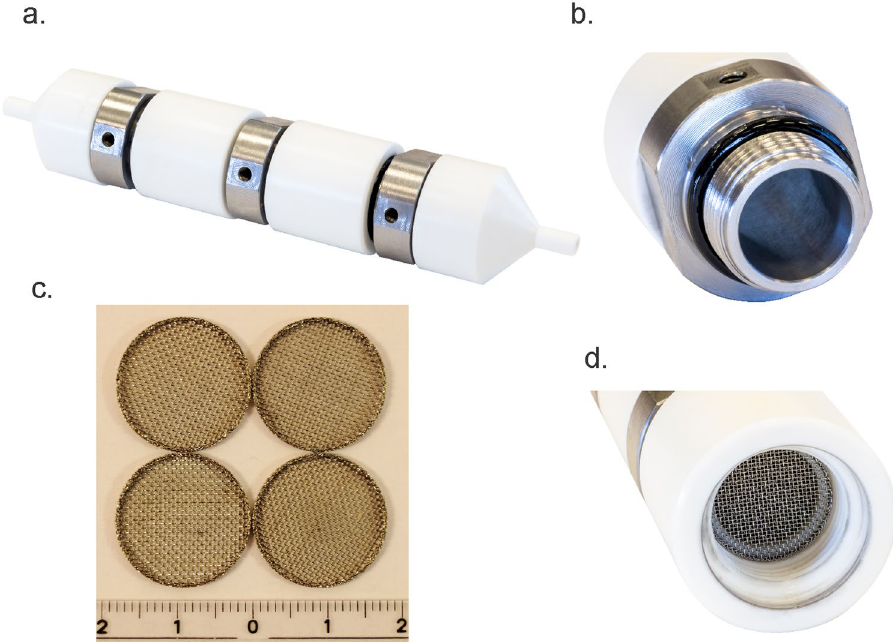
Figure 4. The structure of MSFT chamber ( a ) exterior of assembled chamber with pipelines connections, ( b ) the stainless steel meshes acting as electrodes in one of the two active treatment regions ( c ) the undamaged stainless steel mesh electrodes after PEF treatment with the rule with cm unit labels ( d ) smooth inner surface of the